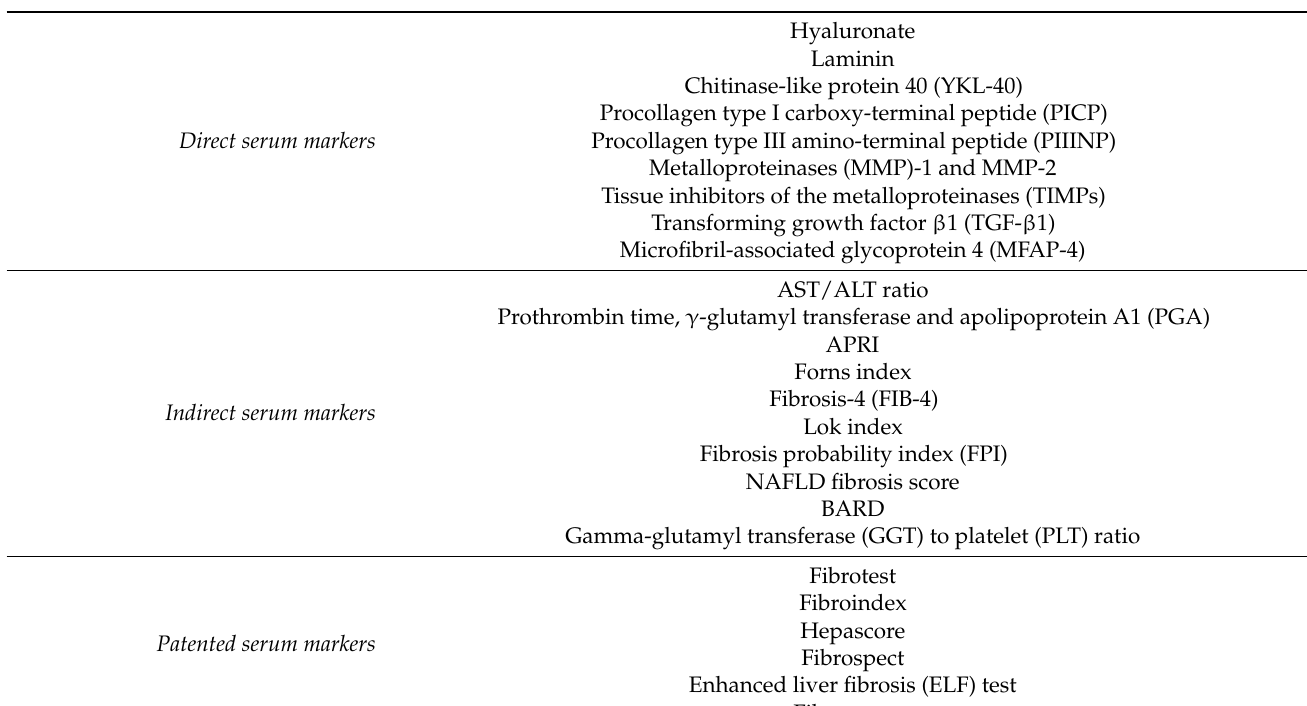
Table 1. Overview of the main non-invasive tests for NAFLD based on blood tests and clinical